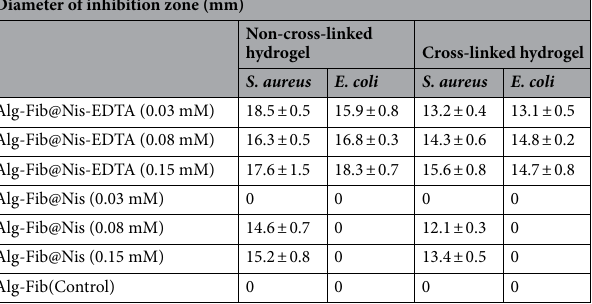
Diameter of inhibition zone